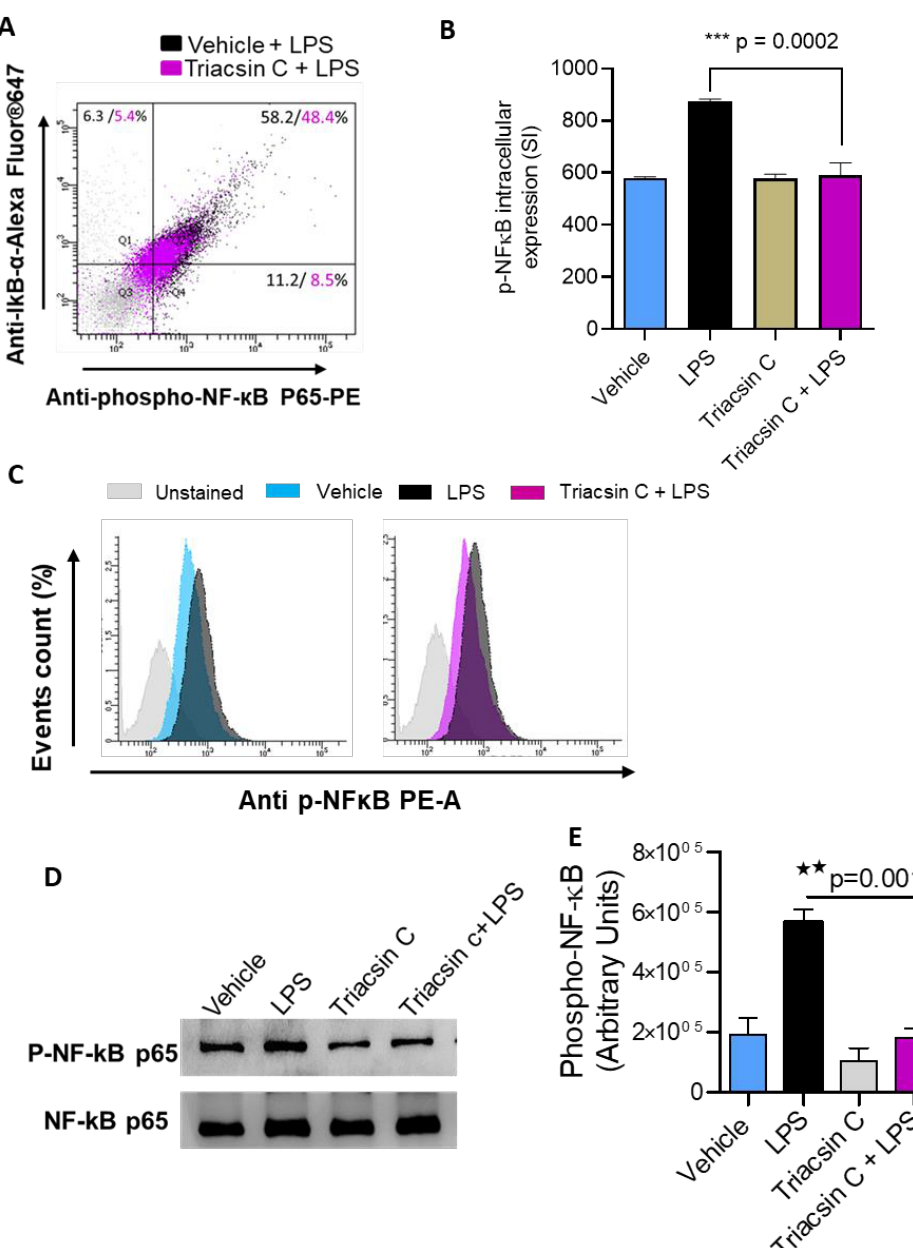
Figure 4. Nuclear factor- κ B (NF- κ B) activation in LPS-treated monocytes was inhibited by triacsin C. MDA-MB-231 cells were pretreated with ACSL1 inhibitor (Triacsin C: (1 µ M) or vehicle for 1 h and then incubated with LPS for 15 min. NF- κ B phosphorylation was determined by flow cytometry. ( A ) Representative flow cytometry dot plots of p-NF- κ B fluorescence versus total inhibitor of kappa B protein alpha (IkB α ) cells. ( B ) Staining intensity of flow cytometry analysis of NF-kB phosphorylation. ( C ) Representative histograms of one experiment. ( D ) MDA-MB-231 were pretreated with ACSL1 inhibitor (Triacsin C: (1 µ M) or vehicle for 1 hr and then incubated with LPS for 15 min. Cell lysates were prepared as described in Materials and Methods. Samples were run on denaturing gels. Phosphorylated NF- κ B is depicted in the upper panel, and total respective proteins are shown in the lower panel. ( E ) Phosphorylation intensity of NF- κ B was quantified using Image Lab software (version 6.0.1, Bio-Rad, Hercules, CA, USA) and are presented in arbitrary units, which indicated that the Western blot protein data for phospho NF-KB and NF-kB clearly exhibited a similar treatment response to that seen that by flow cytometry. All data are expressed as mean ± SEM (n ≥ 3). ** p < 0.01, *** p < 0.001 versus